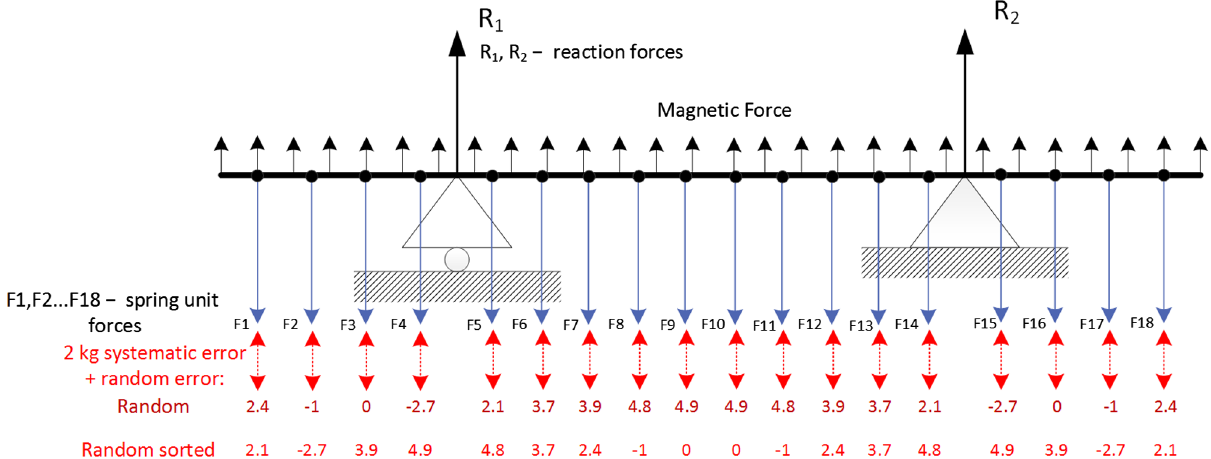
FIG. 8. Schematic of systematic and random errors in spring unit forces (in kg). The magnetic force is uniform along the undulator except for the weaker ends (not shown but accounted for in modeling). The spring unit forces are applied at points F1 – F18. The uniform spacing between F1 – F4 and F15 – F18 is slightly larger than the uniform spacing between F5 – F14. “ Random ” shows the random errors between (cid:1) 5 kg that were added to the systematic 2 kg error. The bottom line shows the sorting of the units according to their random errors. The smallest error is in the undulator ’ s middle; the largest errors are close to the actuator since the actuator compensates for any overall force error to hold the desired gap. (The errors shown are symmetric left to right because the model assumed that symmetry.)